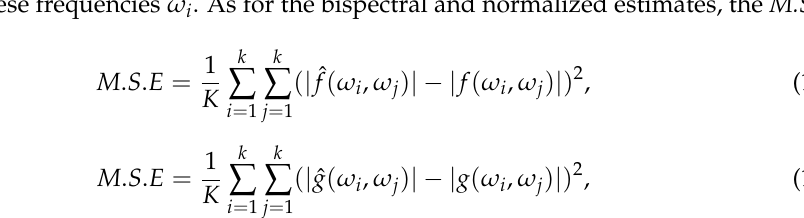
Daniell window with M = 9 from (9) and (17) in two cases: (a) the generated observations from DCGINAR(1), and (b) the forecasted observations for DCGINAR(1) based on fuzzy time series. Figures 7 and 8 represent the estimates of the bispectrum and normalized bispectrum modulus with M=9 by using the Daniell window as in (10), (13), (17) and (18) in two cases: (a) the generated observations from DCGINAR(1), and (b) the forecasted observations for DCGINAR(1) based on fuzzy time